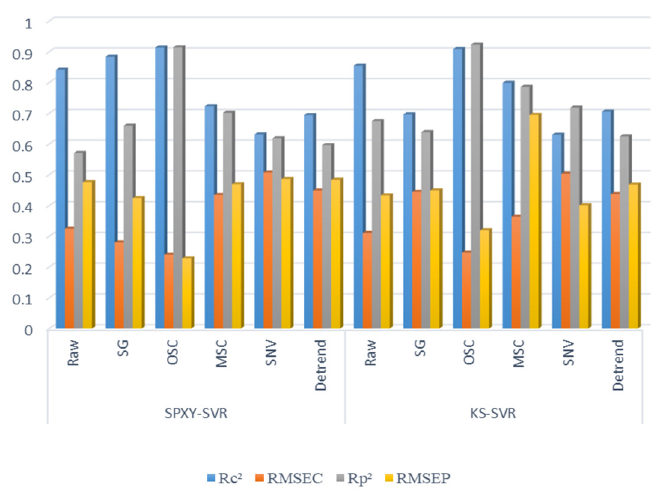
Figure 5. SVR modeling results based on KS and SPXY algorithm